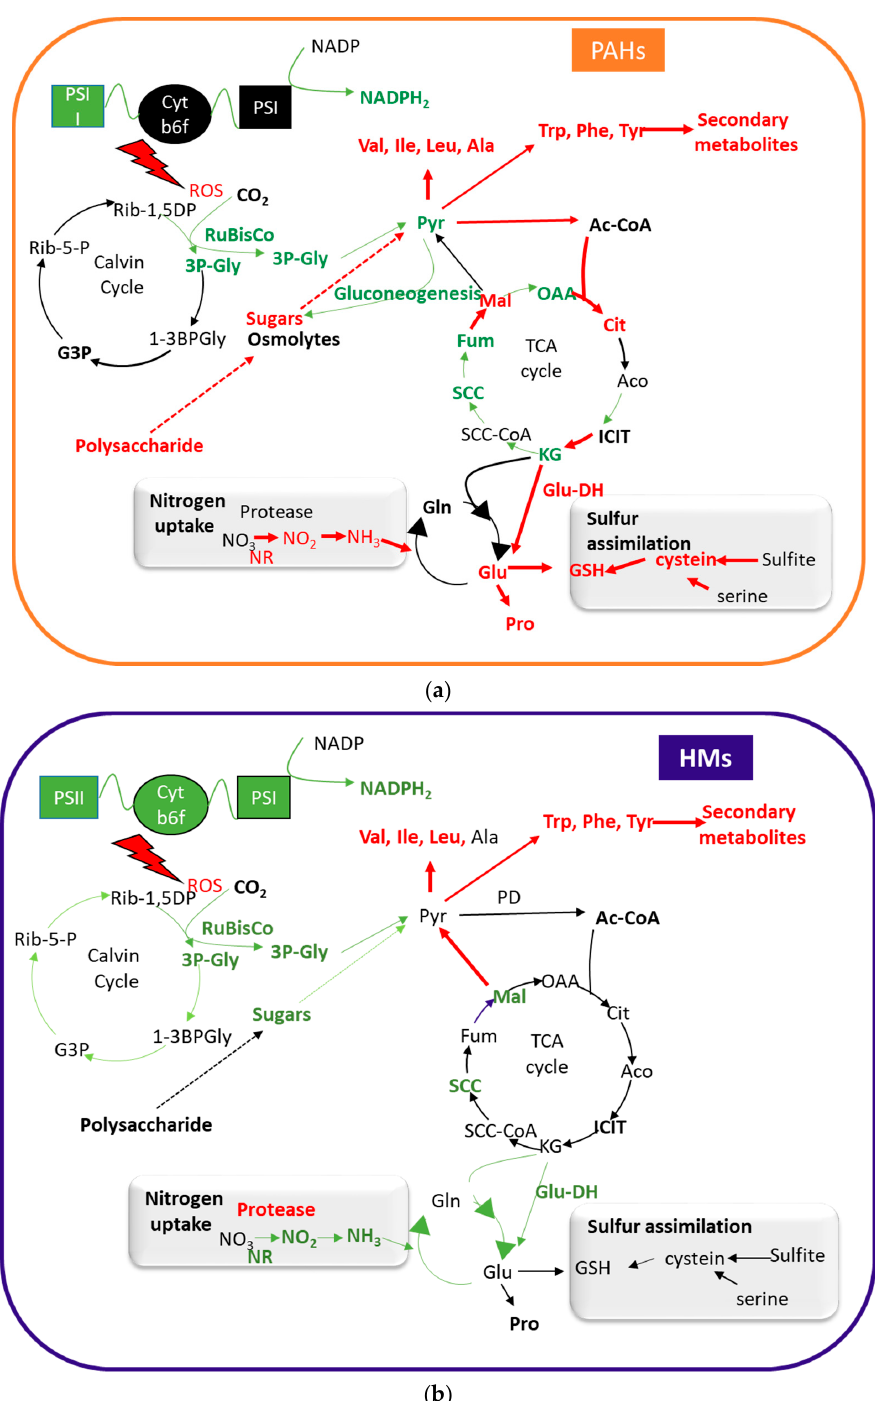
Figure 1. Schematic representation of the metabolic processes that have been reported as induced or repressed in the presence of PAHs ( a ) and HMs ( b ). Red indicates the processes (enzymes and compounds) that are induced in the presence of the contaminants, and green those that are repressed. NR: nitrate reductase; Glu-DH: glutamate dehydrogenase; PD: pyruvate dehydrogenase complex; GSH: glutathione; PSI: phosphosystem I; PSI: phosphosystem II; Cytb6f: cytochrome b6f; Pyr: pyruvate; Ac-CoA: acetyl-CoA; Cit: citrate; Aco: aconitate; ICIT: isocitrate; KG: α -ketoglutarate; SCC-CoA: succinyl-CoA; SCC: succinate; Fum: fumarate; Mal: malate; OAA: oxaloacetate; 3P-Gly: 3-phosphoglycerate; G3P: glyceraldehyde-3-phosphate; Rib-5-P: ribulose 5-phosphate; Rib-1,5DP: ribulose-1,5-bisphosphate; 1-3 BPGly: